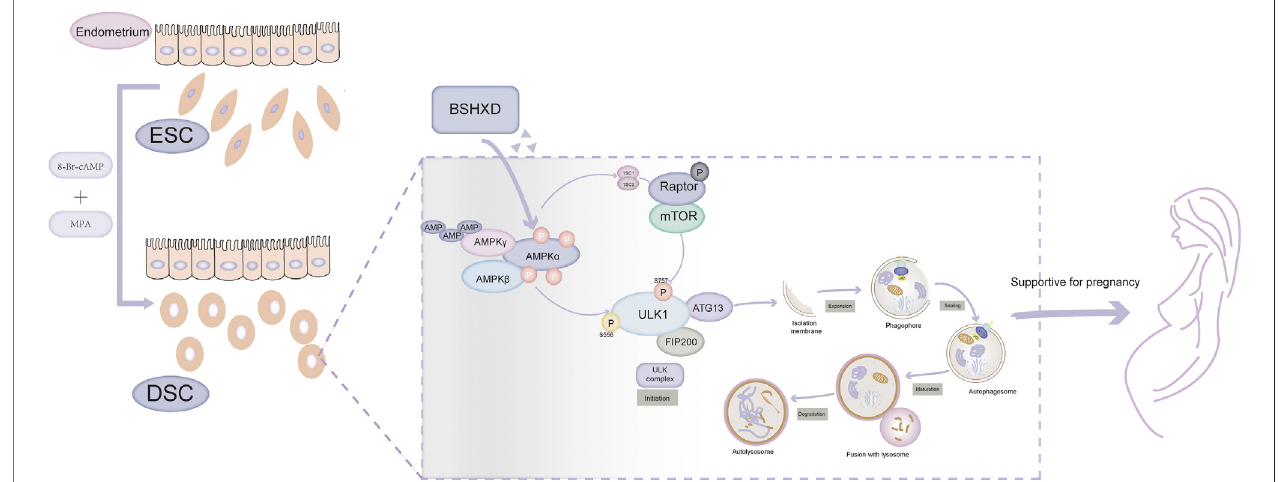
FIGURE 7 | The mechanism of BSHXD on decidualization by intervening autophagy via AMPK/mTOR/ULK1.